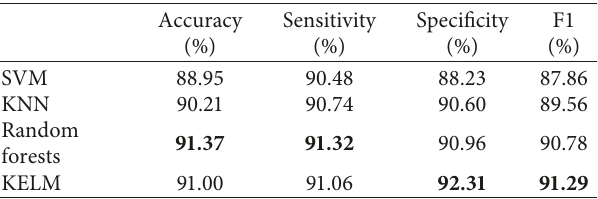
Table 4: Comparison of depression classification methods based on fusion signals (behavior and physiology) and different classification